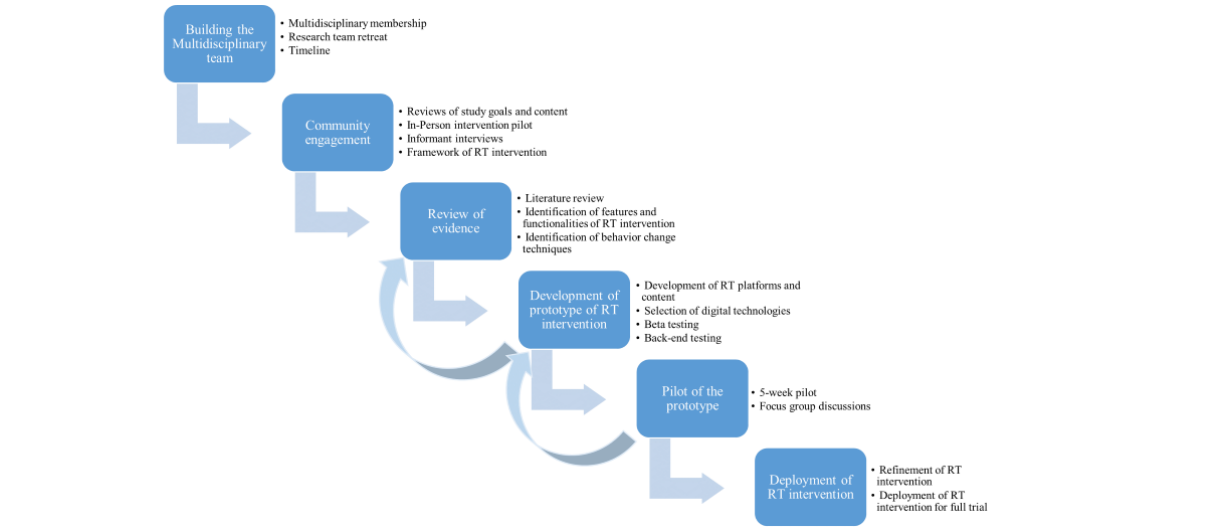
Figure 1. Healthy Frio remote technology (RT) intervention development